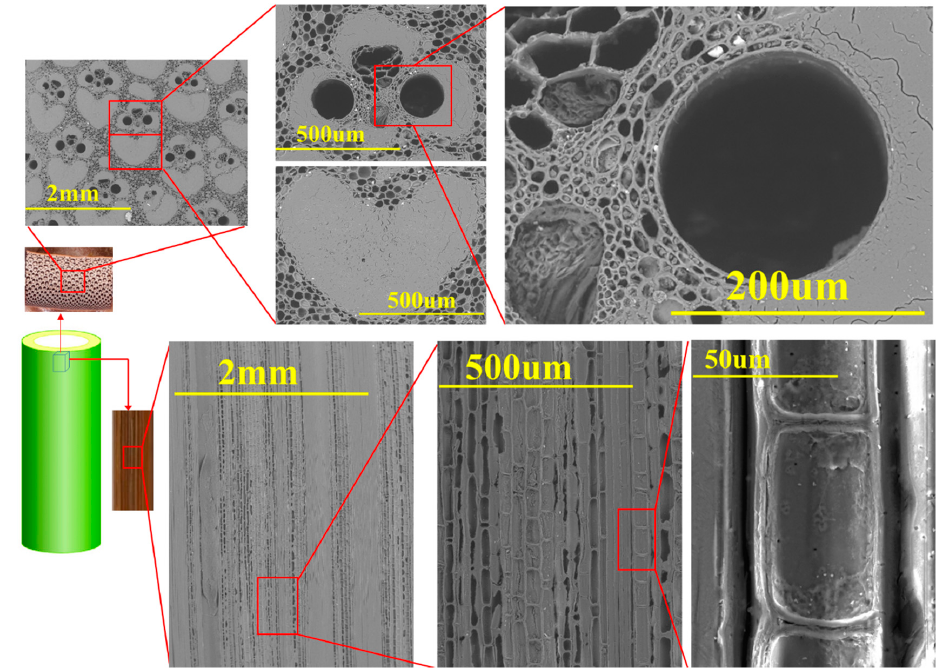
Figure 4. Details of the microstructure of the bamboo D.asper .